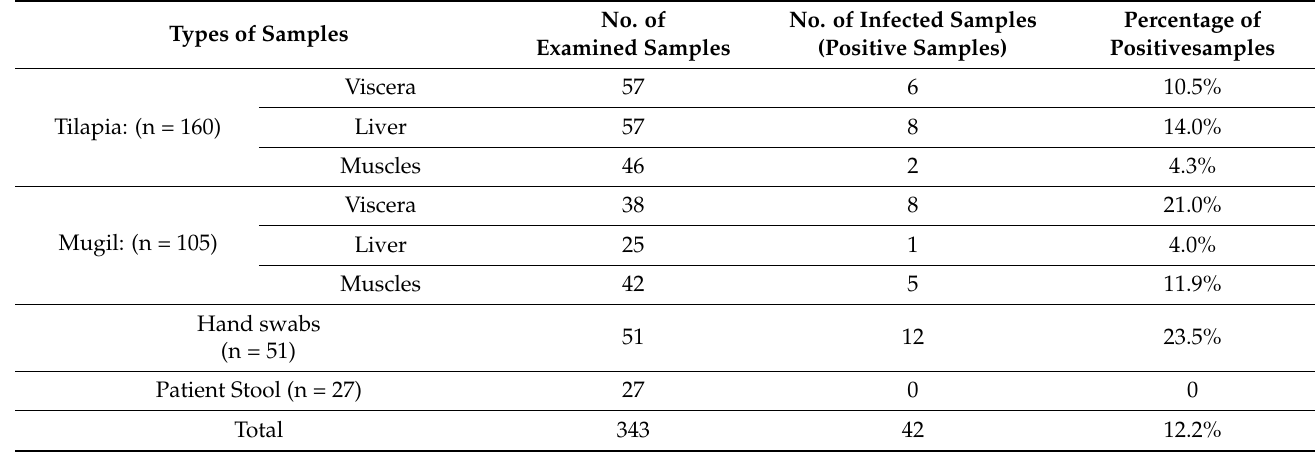
Figure 1. API-20 E biochemical profile of the Aeromonas isolates. Table 2. Incidence (%) of Aeromonas spp. isolated from fish and human